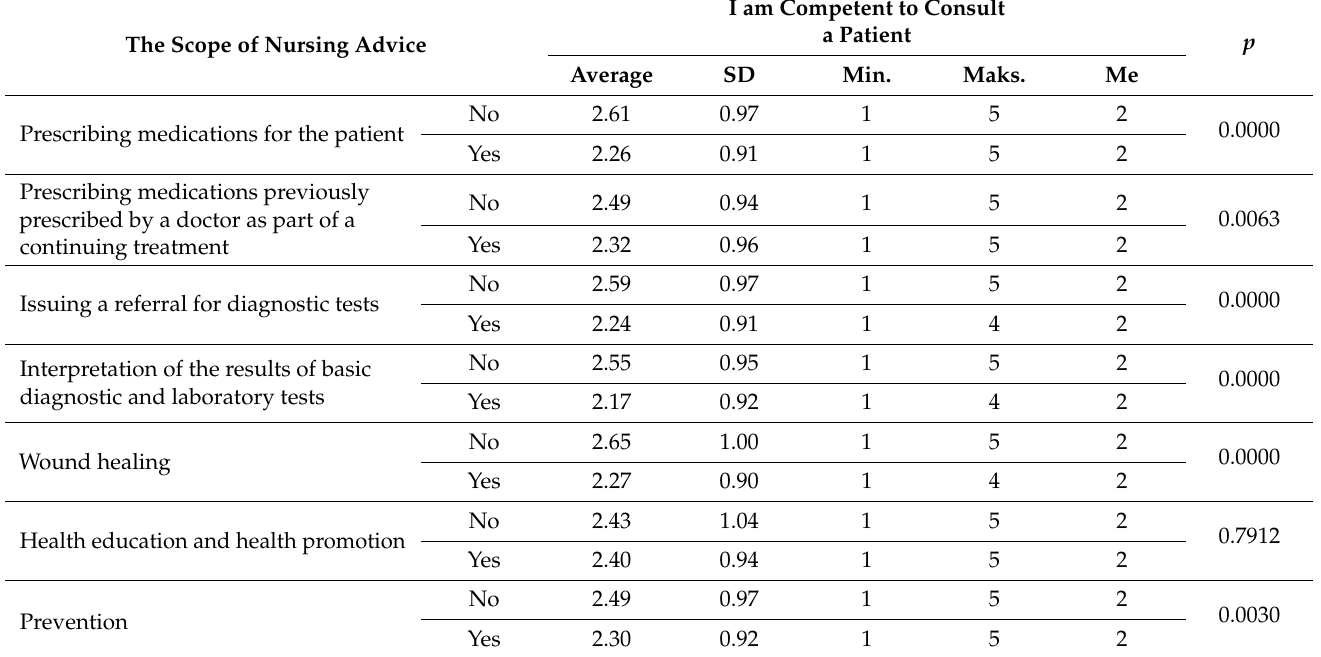
Table 6. Self-assessment of own competences and the preferred scope of nursing